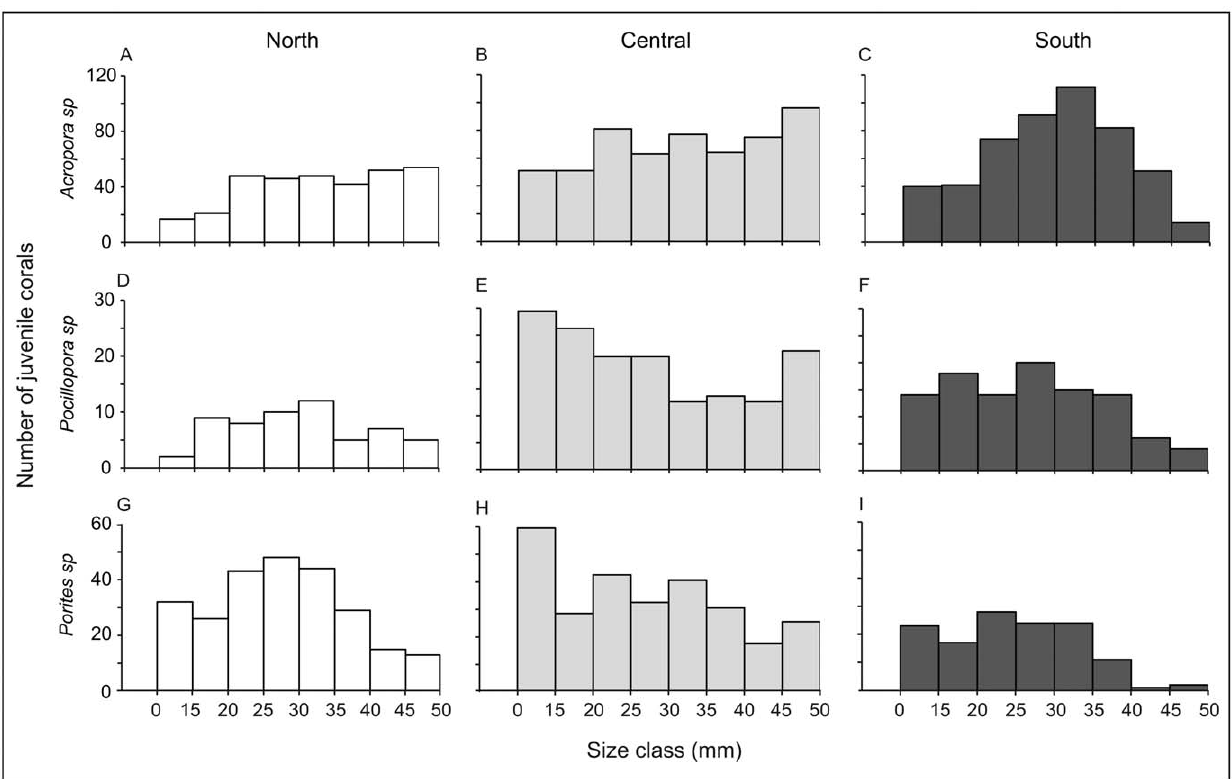
Figure 4. Size-class frequency distribution (mm) of juvenile corals # 50 mm from the three main taxa: (A, B, and C) Acropora , (D, E and F) Pocillopora, and (G, H and I) Poritessp , at the northern ( white ), central ( lightgrey ) and southern ( darkgrey ) sectors of the GBR. Juveniles , 10 mm have been added to the size class 10–14 mm. doi:10.1371/journal.pone.0057788.g004 corals higher at the central sector (13.7%) and Porites corals higher at the northern sector (30.5%, Fig. 3A).